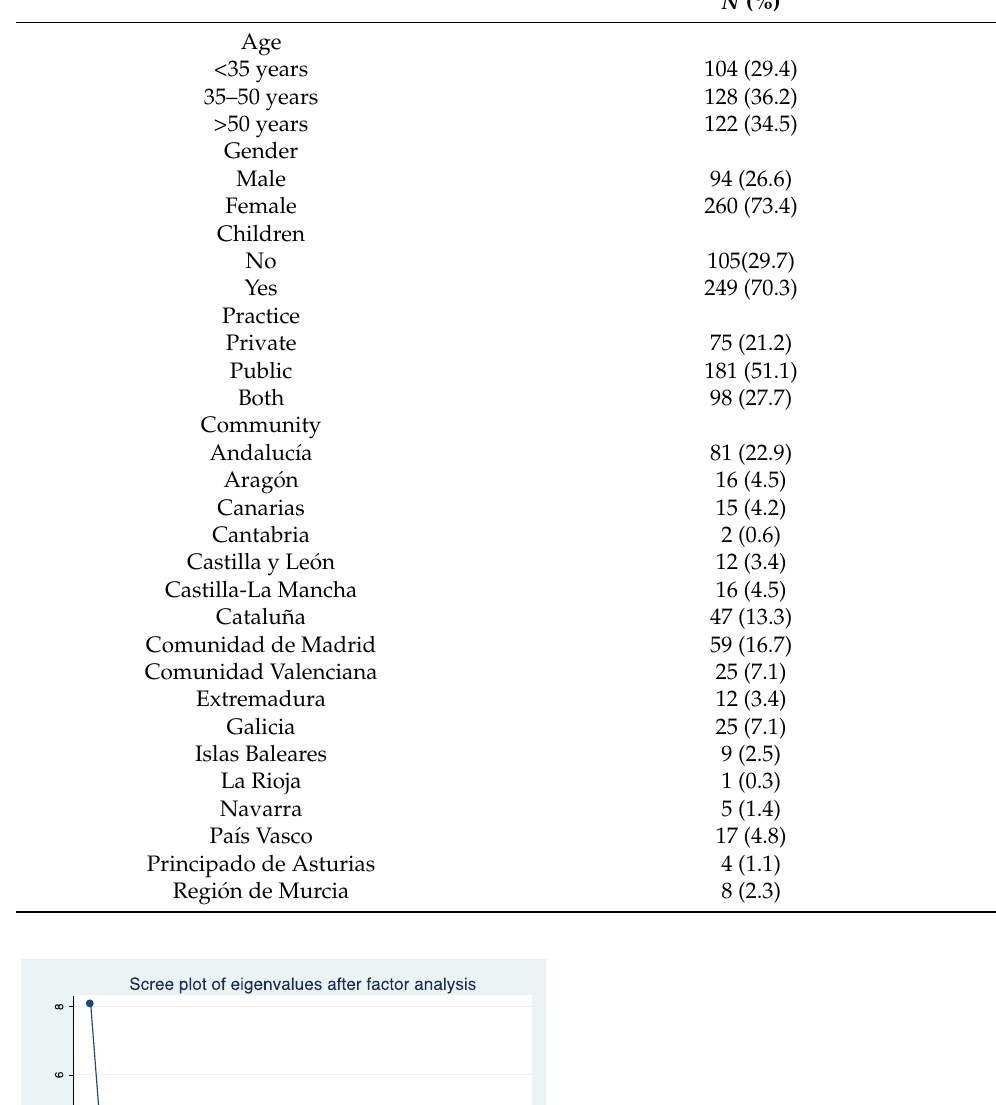
Table 1. Main sociodemographic features of the sample.